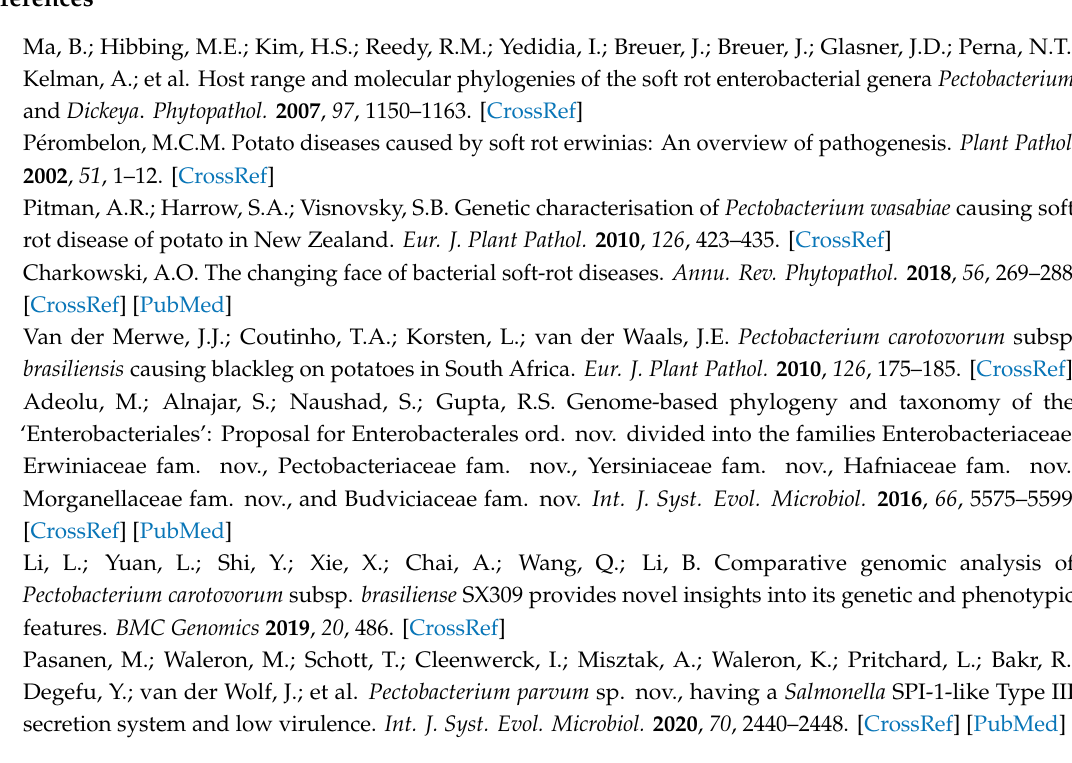
s1, Figure S1: Leaf discs of calla lily or cabbage leaves inoculated with Pectobacterium strains, Figure S2: Assessment of bacterial colonization on leaves, 3 h post inoculation of P. carotovorum WPP14 or P. aroidearum PC16 onto calla lily or cabbage leaf surface, Figure S3: HPLC chromatograms of phenolics extracted from Calla lily and Cabbage, that served for the assays, Figure S4: Growth of Pectobacterium strains PC16 and WPP14 in MM in the presence of non-lethal volumes (40 µ L extract / 200 µ L LB) of phenolic extracts from calla lily or cabbage leaves, Figure S5: Expression levels of virulence genes ( expI , expR , pel and peh ) in Pectobacterium strains PC16 and WPP14 in MM in the presence of phenolic extracts from calla lily and cabbage